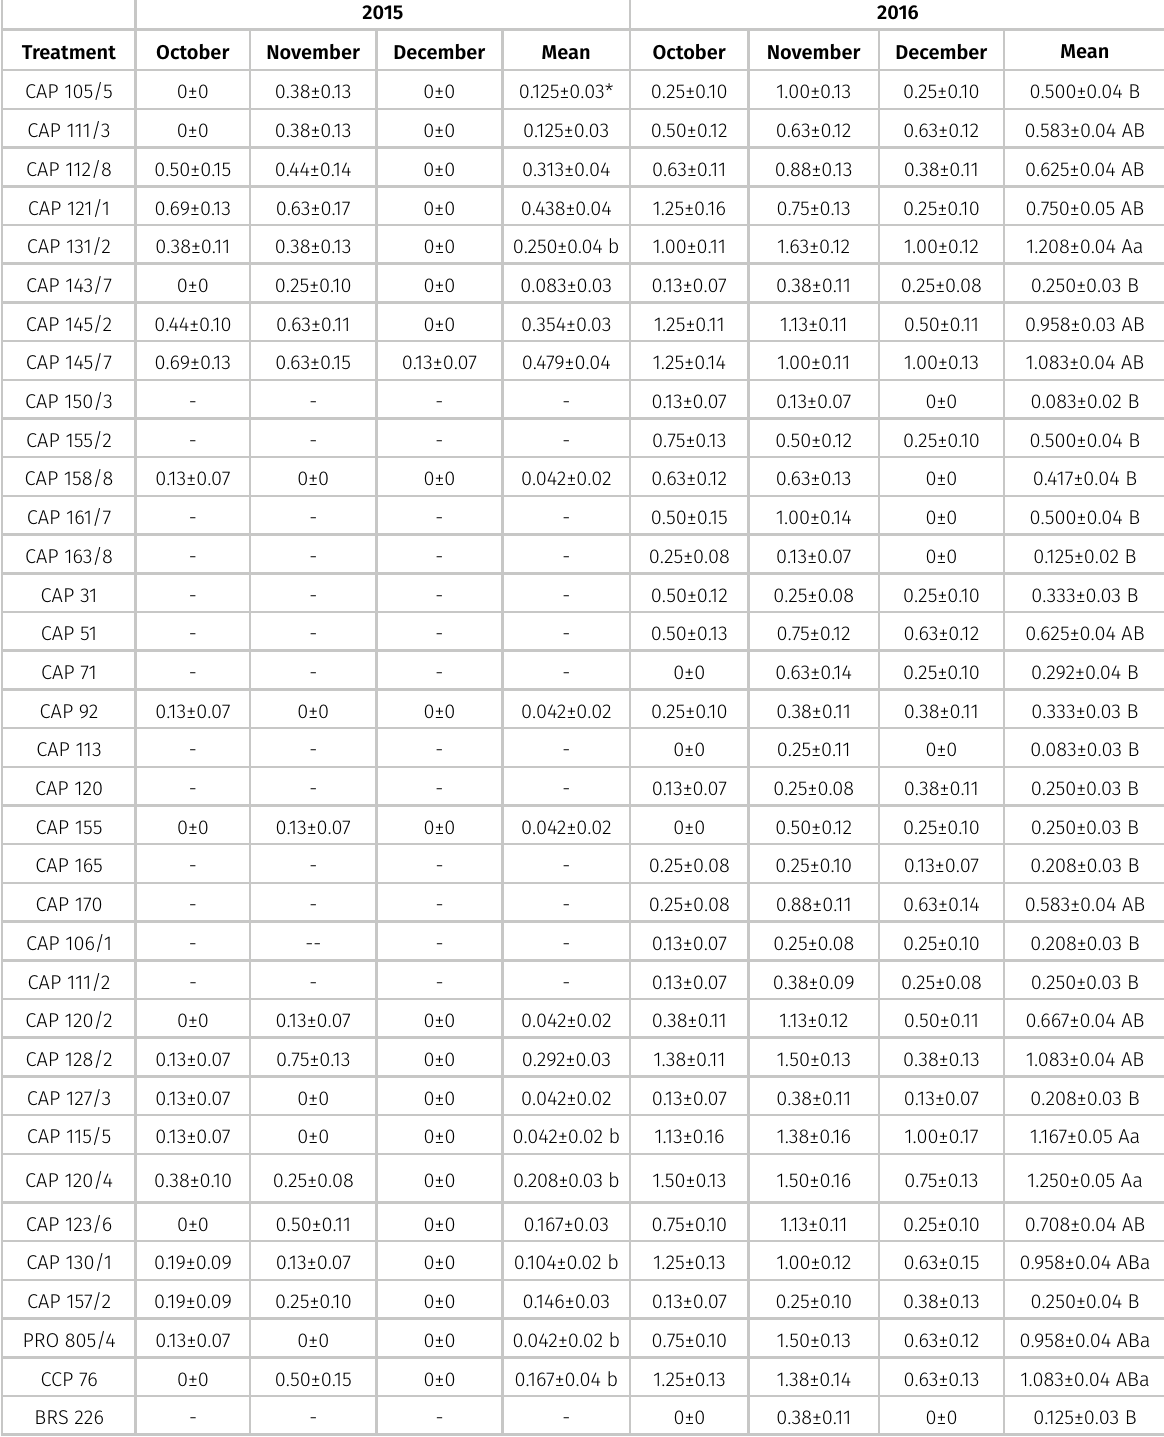
Table III. Mean scores of H. fulvus infestation in crop years 2015/2016. Means followed by the same uppercase letter in the column and lowercase letter in the row do not differ statistically from each other by Tukey test (P < 0.05), *letters only where there is statistical